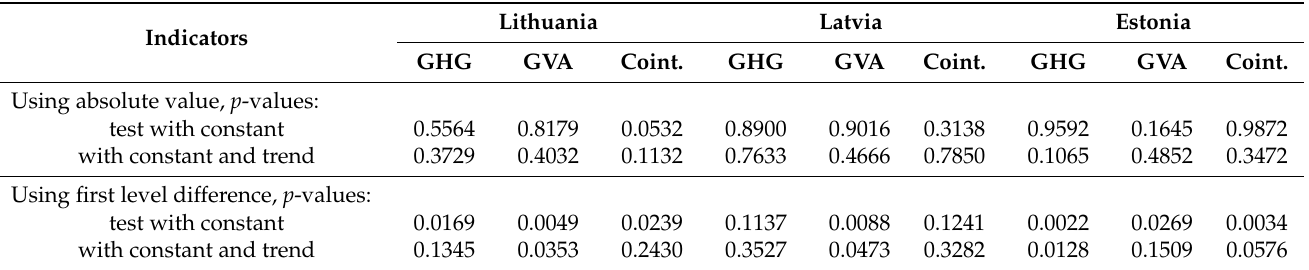
Table 2. Augmented Dickey–Fuller test and Engle–Granger cointegration test results.